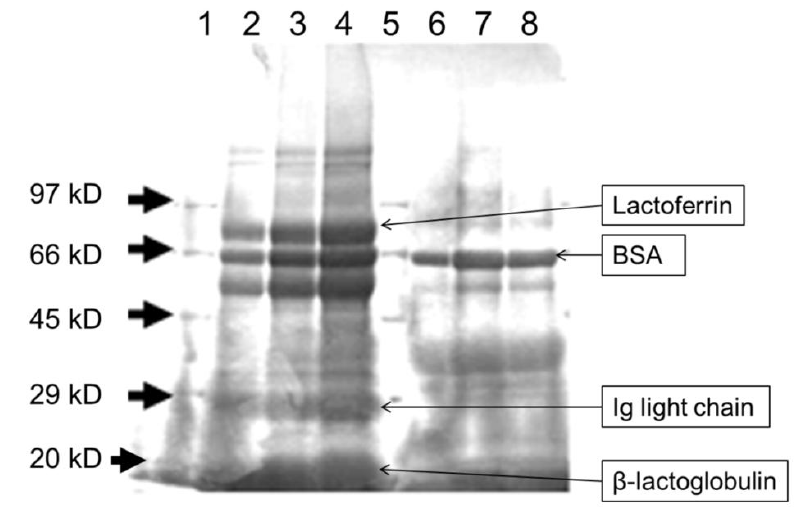
Figure 1. SDS-PAGE profiles of whey protein concentrates. Lanes 1 and 5: marker; lanes 2–4: low-temperature-processed whey protein concentrate (LWPC); lanes 6–8: high-temperature-processed whey protein concentrate